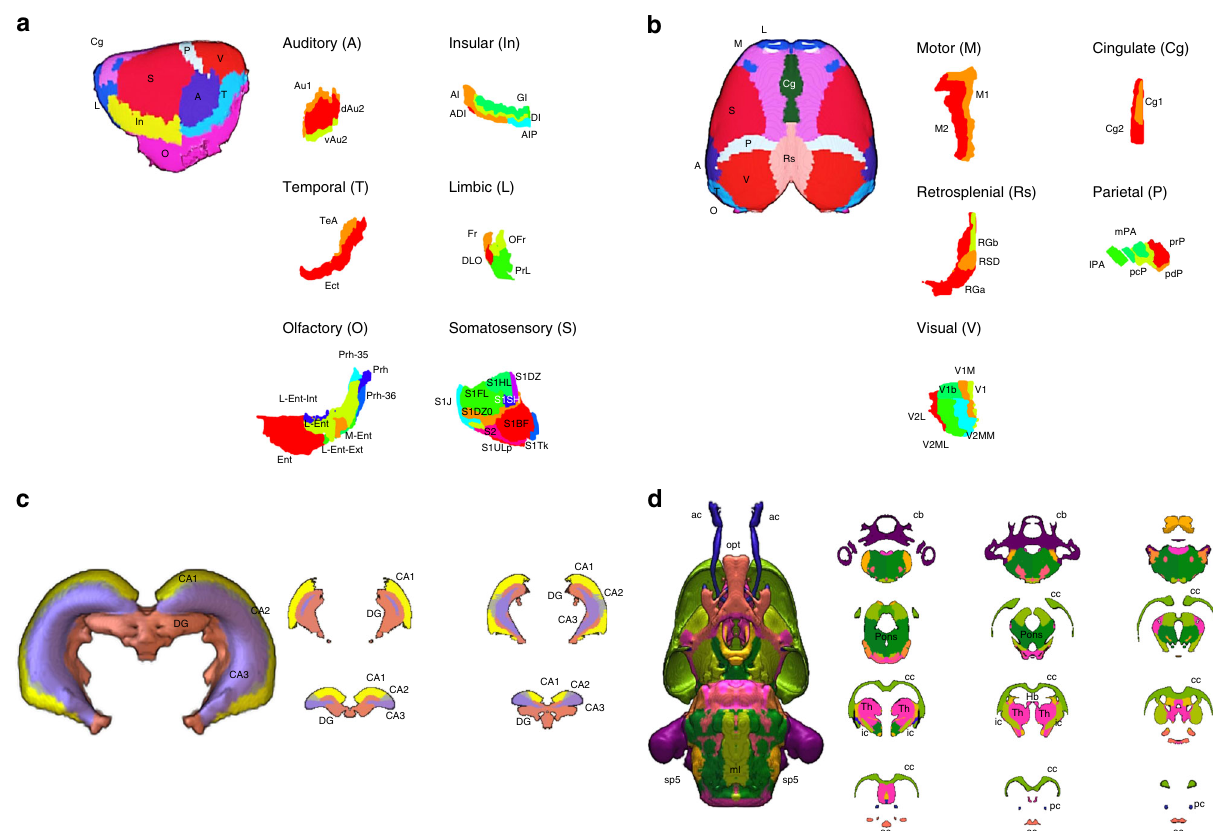
Fig. 5 Cortical and sub-cortical details of the SIGMA anatomical atlas. a , b Lateral and dorsal views of the cortical areas after normalization of the Tohoku atlas to the SIGMA anatomical template. The cortex has been segmented into cortical areas such as auditory (A), insular (In), temporal (T), limbic (L), olfactory (O), somatosensory (S), motor (M), cingulate (Cg), retrosplenial (Rs), parietal (P) and visual (V). Each area has been subdivided (using the Paxinos-Watson atlas) into functional areas (i.e. primary and secondary motor cortices) or structural areas (i.e. agranular, dysgranular, agranular/ dysgranular, granular and posterior agranular insular cortices). c , d Lateral and dorsal views of sub-cortical structures (hippocampus and white matter tracts) after normalization of the Waxholm atlas on the SIGMA anatomical template. Legend of labeled regions: − Auditory: Au1 = primary auditory cortex; dAu2, vAu2 = secondary auditory cortex, dorsal and ventral areas. − Insular: AI, ADI = agranular insular and dysgranular insular cortices; GI, DI = granular and dysgranular insular cortices; AIP = posterior agralunar insular cortex. − Temporal: TeA = temporal association cortex; Ect = ectorhinal cortex. − Limbic: Fr = frontal association cortex; DLO = dorsolateral orbital cortex; OFr = orbitofrontal region; PrL = prelimbic cortex. − Olfactory: Prh = perirhinal cortex; Prh-35, Prh-36 = perirhinal areas 35 and 36; Ent = entorhinal cortex; L-Ent, M-Ent = lateral and medial entorhinal cortices; L-Ent-Int, L-Ent-Ext = lateral entorhinal cortex, internal and external parts. − Somatosensory: S1J, S1FL, S1HL, S1SH, S1ULp, S1Tk, S1BF = primary somatosensory cortex, jaw, forelimb, hindlimb, shoulder, upper lip, trunk and barrel fi eld regions; S1DZ, S1DZ0 = primary somatosensory cortex, dysgranular region and dysgranular zone 0; S2 = secondary somatosensory cortex. − Motor: M1, M2 = primary and secondary motor cortices. − Cingulate: Cg1, Cg2 = primary and secondary cingular cortices. − Retrosplenial: RGa, RGb = retrosplenial granular A and B cortices; RSD = retrosplenial dysgranular cortex. − Parietal: lPA, mPA = lateral and medial parietal associative cortices; pcP, pdP, prP = parietal cortex postero-caudal, dorsal and rostral parts. − Visual: V1 = primary visual cortex; V1b, V1M = primary visual cortex, binocular and monocular areas; V2L = secondary visual cortex, lateral area; V2ML, V2MM = secondary visual cortex, mediolateral and mediomedial areas. − Hippocampus: CA1, CA2, CA3 = cornu ammonis areas; DG = dentate gyrus. − White matter tracts: ac = anterior commissure; cc = corpus callosum; f = fornix; Hb = habenular commissure; ic = internal capsule; ml = medial lemniscus; opt = optic tract; pc = posterior commissure; sp5 = spinal trigeminal 5 tract; Th =